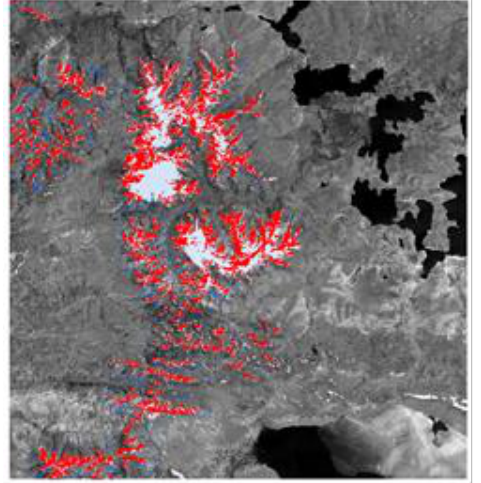
Figure 5. The glacier change detection result from 2004- 2007 The change detection result shows that glacier decreased area within the research area is 215.83km² from 2004 to 2007, while glacier increased area is 28.04 km². The total glacier change area is 187.79 km², and the annual average change speed is 62.60 km²·a -1 , which indicates a severe glacier decrease situation. The same change detection process is operated on another two differential images. The change detection result is shown in Figure 6. Figure (a) is the glacier change detection result from 2007 to 2011, and Figure (b) is the glacier change detection result from 2011 to